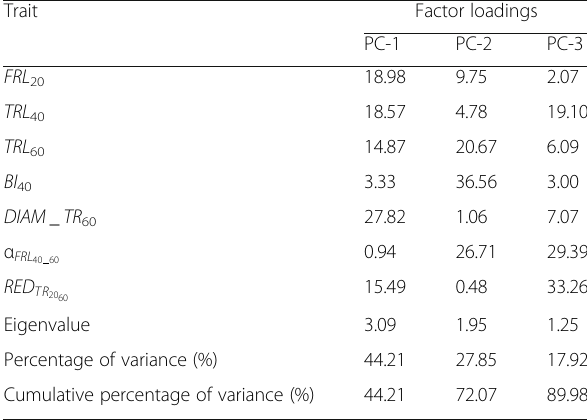
Table 3 Trait loading scores of the selected root traits and the proportion of variation for each principal component under irrigated